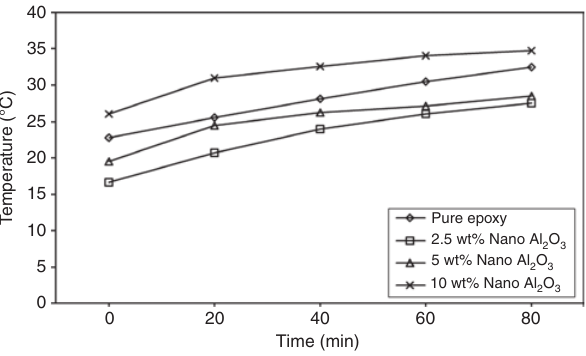
O -filled epoxy 2 3